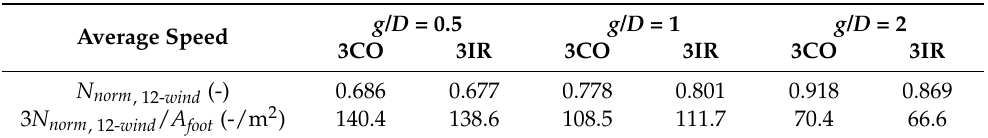
Table 3. Comparison of average normalized rotational speed N norm , 12- wind and 3 N norm , 12- wind / A foot in a trio of VAWT models in an isotropic 12-directional wind speed.